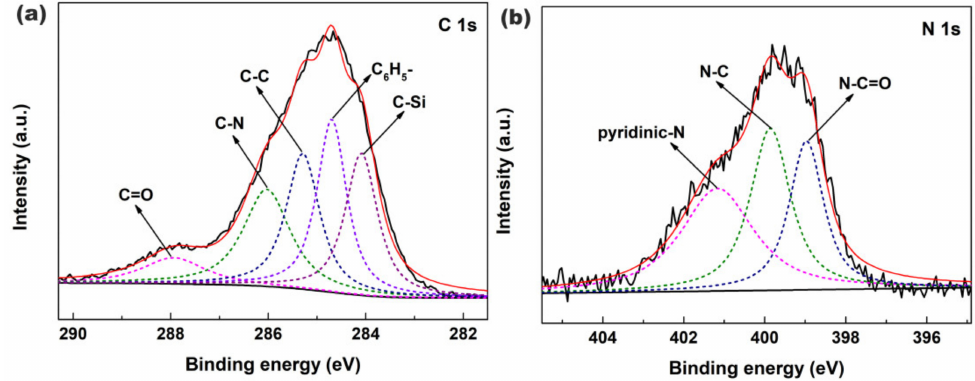
Figure 5. XPS spectra of ( a ) C 1s and ( b ) N 1s core-levels of Fe 3 O 4 @SiO 2 -BPMA powders.